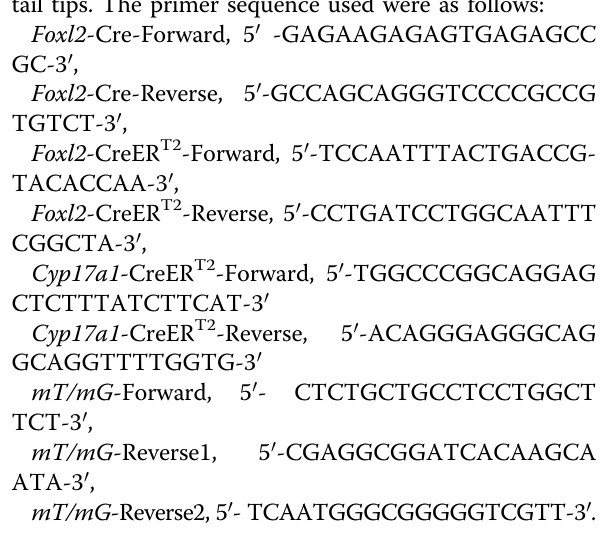
table. Immunolabelled sections were imaged with a con- focal laser scanning microscope (Zeiss 880).